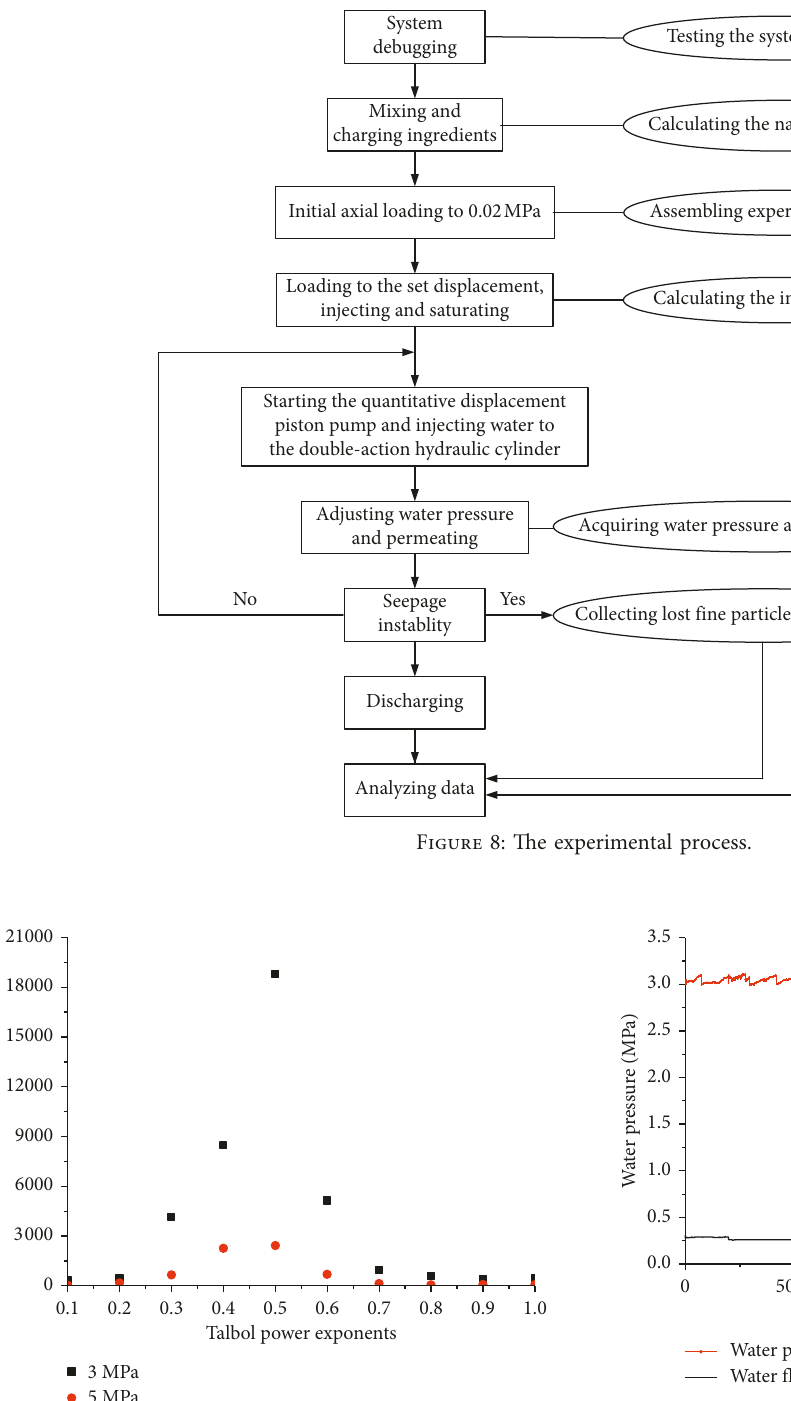
Figure 9: The distribution of permeate times of different Talbol power exponents.